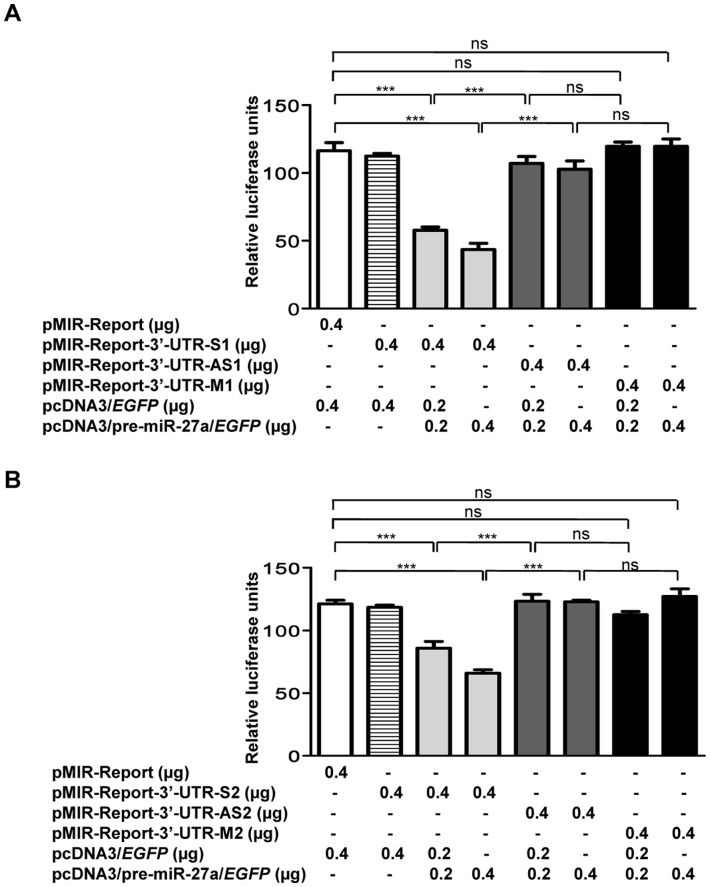
miR-27a targets both the seed regions of MCPH1 cloned separately.
(A) The luciferase reporter assay of different constructs harboring seed region 1 (SDR1) of MCPH1 3′-UTR in KB cells. Note a significantly reduced luciferase activity in cells co-transfected with pMIR-Report-3′-UTR-S1 and pcDNA3/pre-miR-27a/EGFP (0.2 or 0.4 µg) in comparison to those with pMIR-Report, suggesting miR-27a targets SDR1 of MCPH1. As expected, no significant difference in luciferase activity was observed in cells co-transfected with pMIR-Report-3′-UTR-AS1 or pMIR-Report-3′-UTR-M1 with pcDNA3/pre-miR-27a/EGFP (0.2 or 0.4 µg) in comparison to those with pMIR-Report. (B) The luciferase reporter assay of different constructs harboring seed region 2 (SDR2) of MCPH1 3′-UTR in KB cells. As with SDR1, miR-27a also targets SDR2.